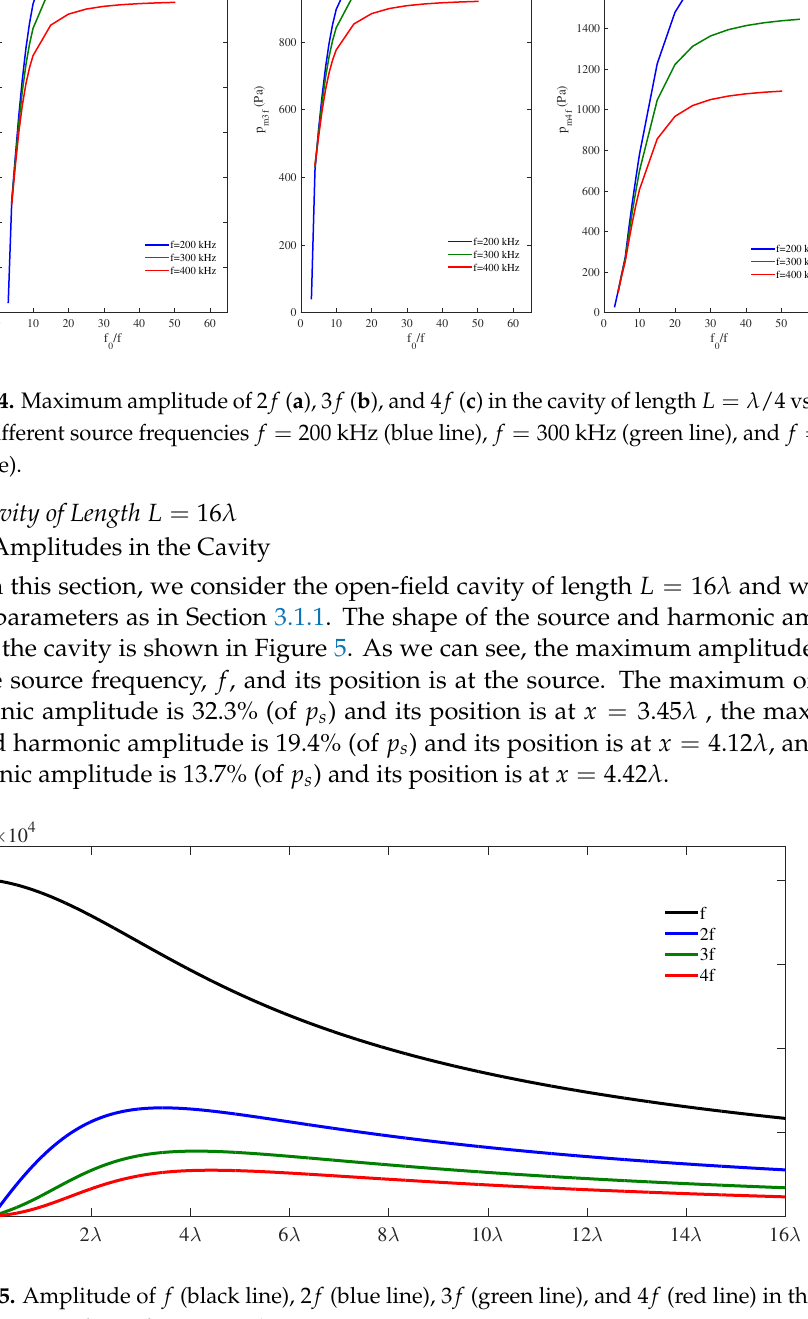
Figure 5. Amplitude of f (black line), 2 f (blue line), 3 f (green line), and 4 f (red line) in the cavity of length L = 16 λ /4 vs. for p s = 20